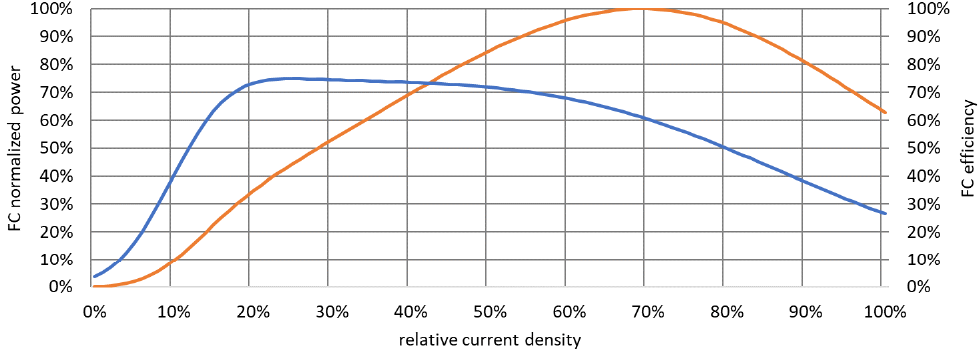
Figure 6. PEM-FC normalized power (orange) and efficiency (blue) over the relative stack current density, as expected for 2050 [44,46–48].